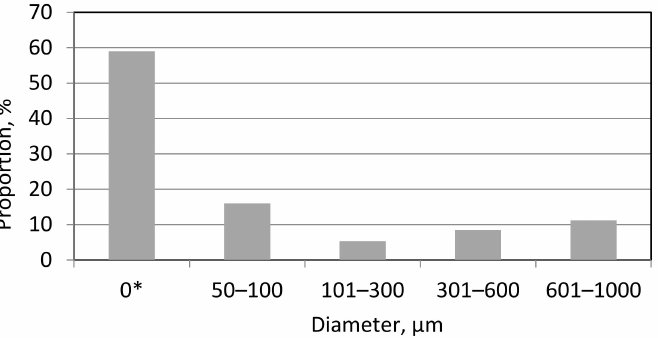
Figure 3. Distribution of infection sites by colony size during the development of P. graminis f. sp. tritici (isolate with IT ;, 2, 3+) in the tissues of cv. Bacanora. 0*—development stopped at the stage of the substomal